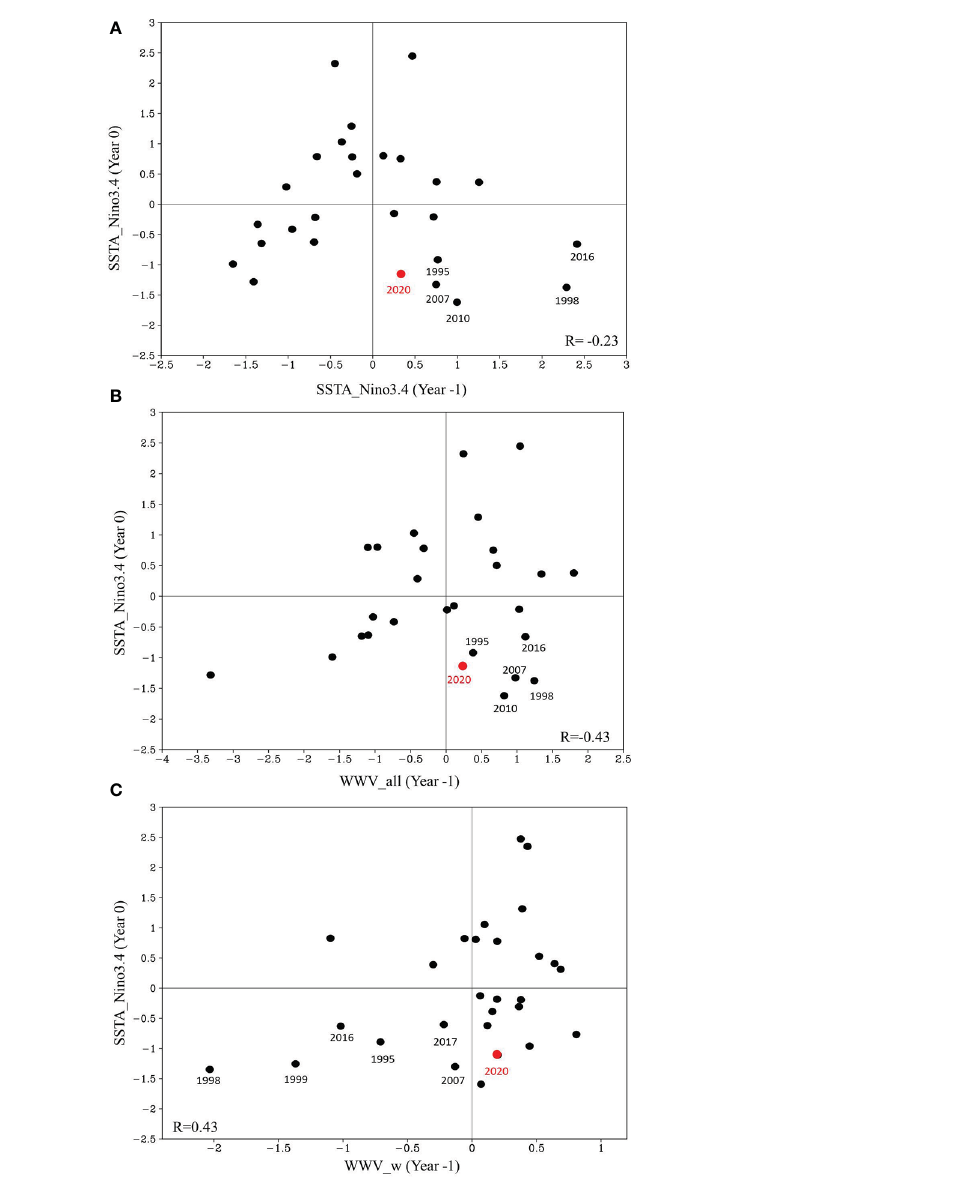
FIGURE 2 Relationship of the (A) Niño3.4, (B) WWV in the equatorial Paci fi c (WWV_all) and (C) WWV in the western equatorial Paci fi c (WWV_w) in fall with the Niño3.4 index one year later. Correlation coef fi cients in the fourth quadrant are shown in the lower right of (A, B) , correlation coef fi cient in the third quadrant is shown in the lower left of (C)